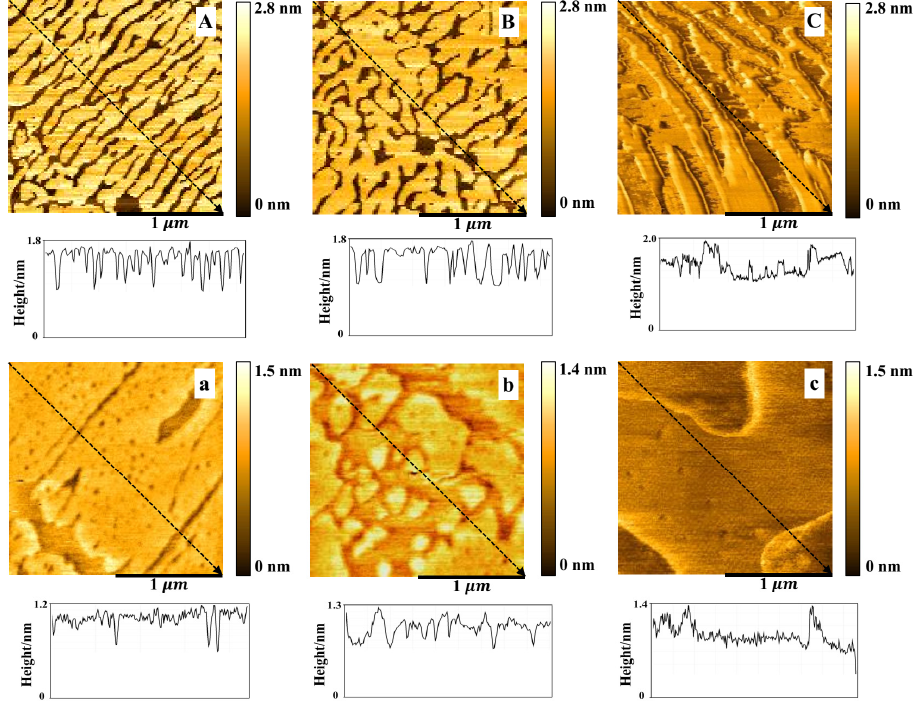
Figure 6. The AFM images ( 2 μm × 2 μm ) of the DPPC/Chol mixed Langmuir–Blodgett film without ( A , B , C ) and with AmB ( a , b , c ) in the absence ( A , a ) and presence of 5 mmol/L ( B , b ) and 10 mmol/L ( C , c ) K + ions at 30 mN/m.